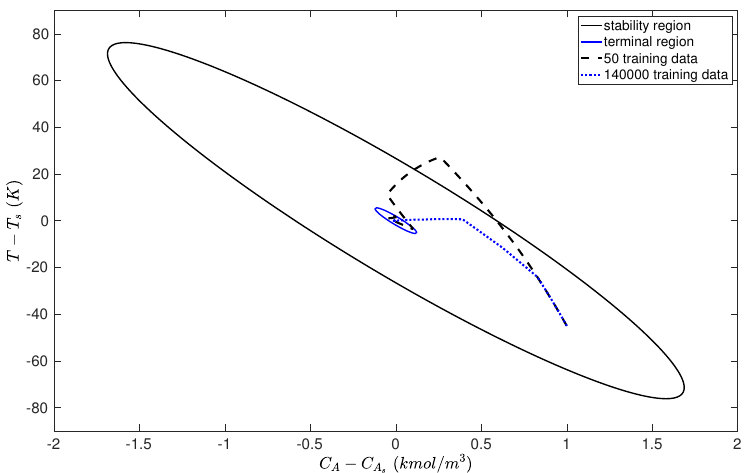
Figure 11. Closed-loop state trajectory under LMPC using two RNN models trained with different data sample sizes.